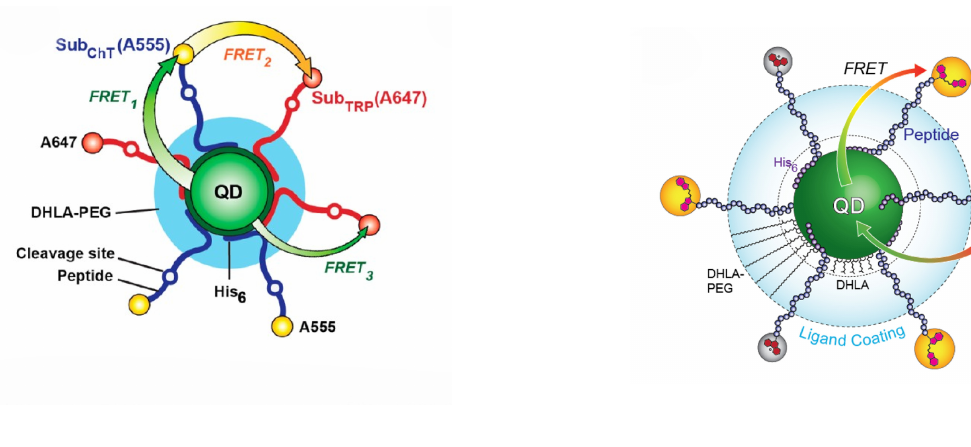
Figure 6. ( left ) Design of the concentric FRET relay and three possible energy transfer pathways between the QD, A555, and A647. The dye-labeled peptide substrates (Sub) are